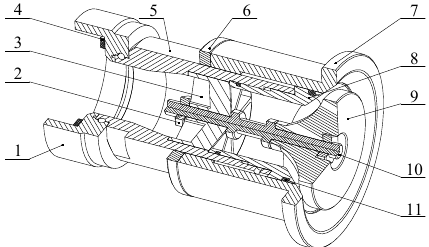
Figure 1. Structure of a traditional diversion gun head. 1. Joint; 2. Nut; 3. Regulator; 4. Gasket; 5. Enclosure; 6. Ring; 7. Outer nozzle; 8. Inner nozzle; 9. Spray core; 10. End cap; 11. Core rod.